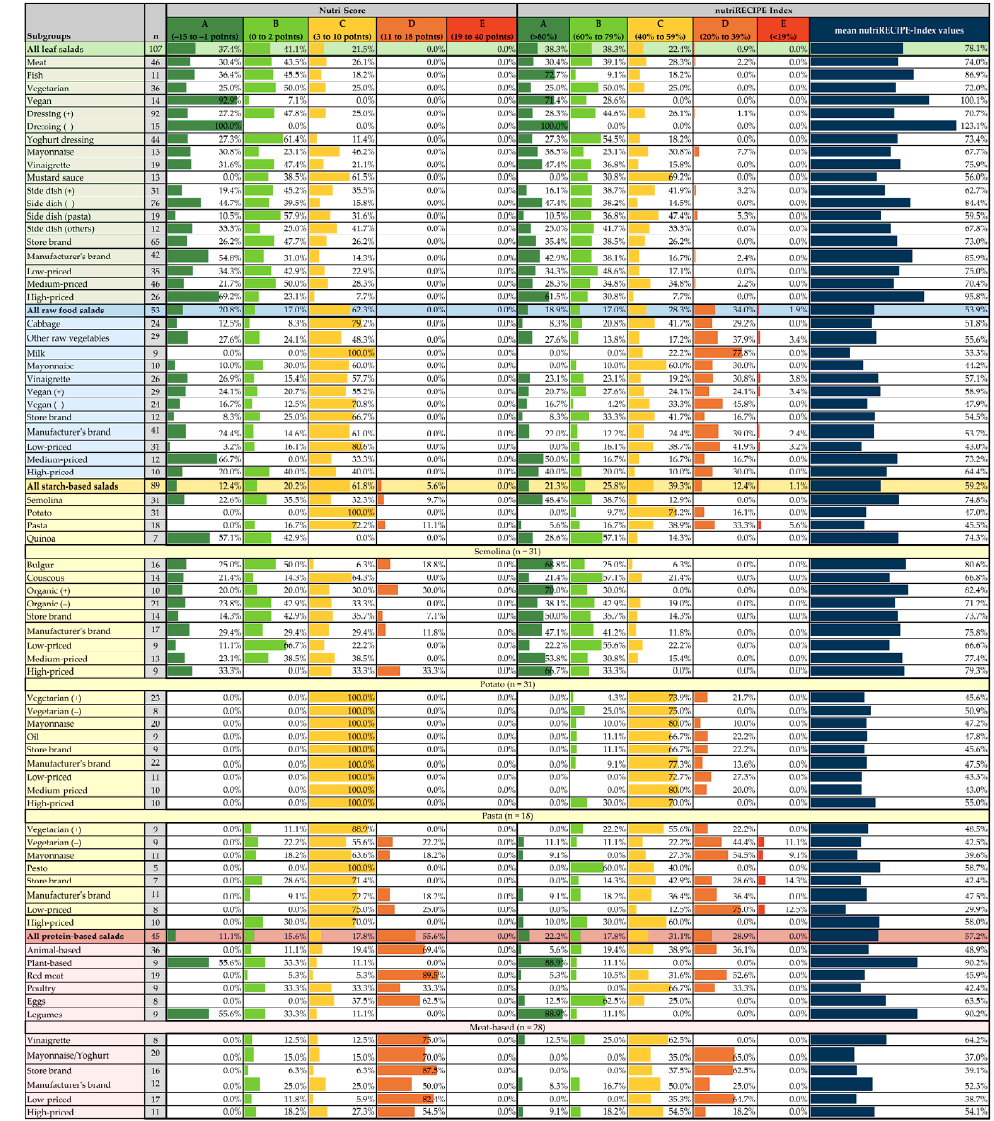
Figure 2. Comparison of the mean nutriRECIPE-Index values with the respective Nutri-Score